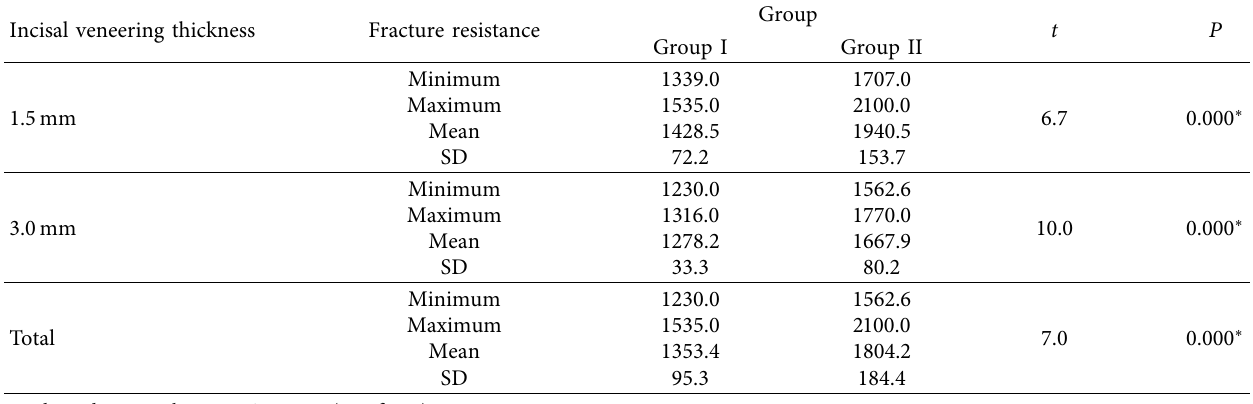
Figure 17: Mode II (veneer chipping) under stereomicroscope: (a) all-ceramic; (b) metal ceramic. Table 4: Comparison between the two studied groups according to the fracture resistance in each incisal veneering thickness and in both thicknesses.